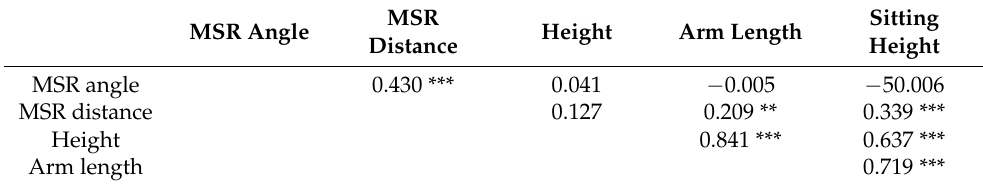
Table 3. Intercorrelations of the MSR angle, the MSR distance, height, sitting height and arm length in all participants ( n = 194).